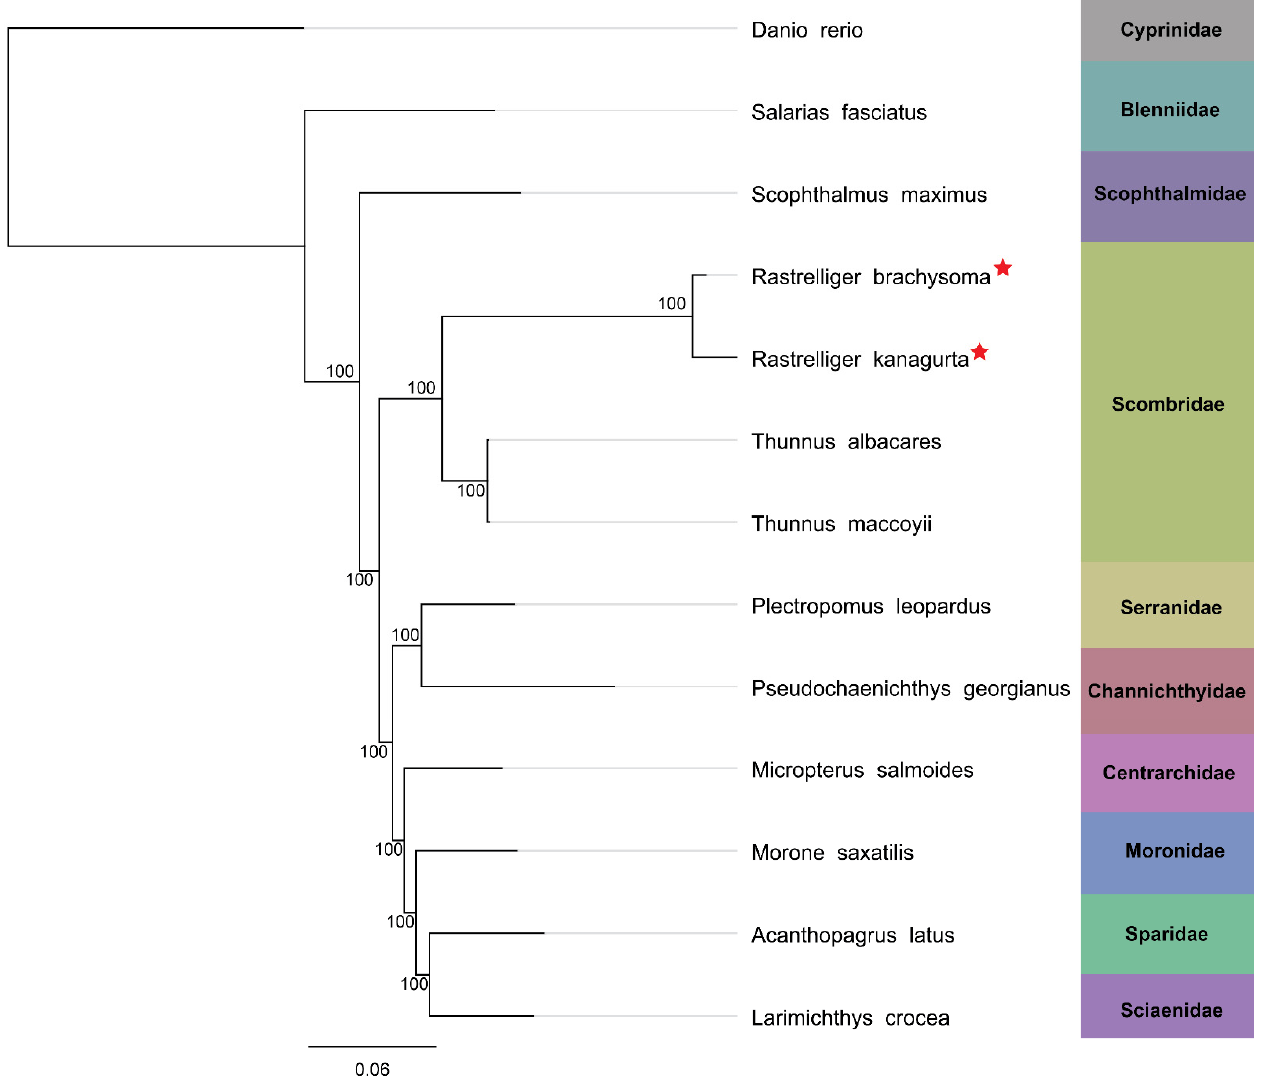
Figure 5. The phylogenetic tree was inferred from 305 single-copy ortholog genes from 13 species using the neighbor-joining method with 1000 bootstrap replicates in the Geneious software, setting zebrafish as an outgroup. The red star represents the species used in this study.